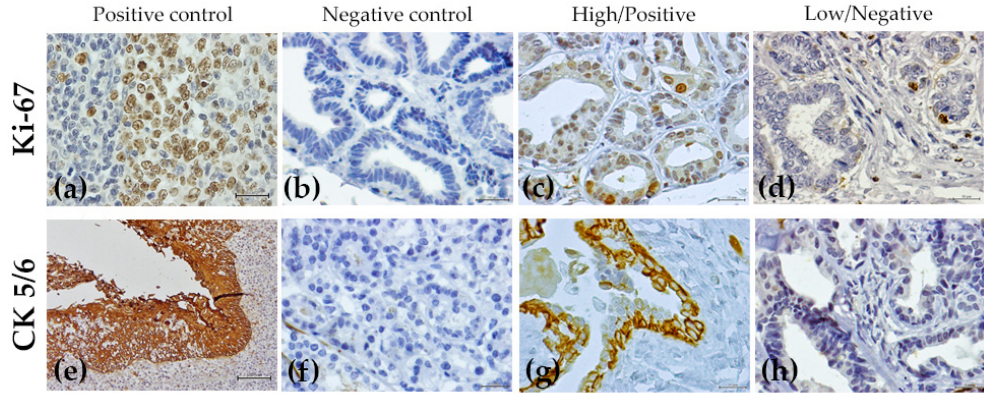
Figure 2. Immunohistochemical expression of the Ki-67 and CK5/6 proteins in non-neoplastic benign tumors and in benign tumors: ( a ) Ki-67 positive control, feline tonsil; ( b ) negative control for Ki-67; ( c ) simple adenoma presenting a high Ki-67 proliferation index (29%); ( d ) fibroadenomatous change with low Ki-67 index (1%); ( e ) positive control for CK5/6, oral epithelium (100 × ); ( f ) CK 5/6 negative control; ( g ) ductal ectasia presenting a positive staining for CK5/6 and; ( h ) a simple adenoma with a negative score for CK5/6. All the samples were counterstained with Mayer’s hematoxylin (400 × ).